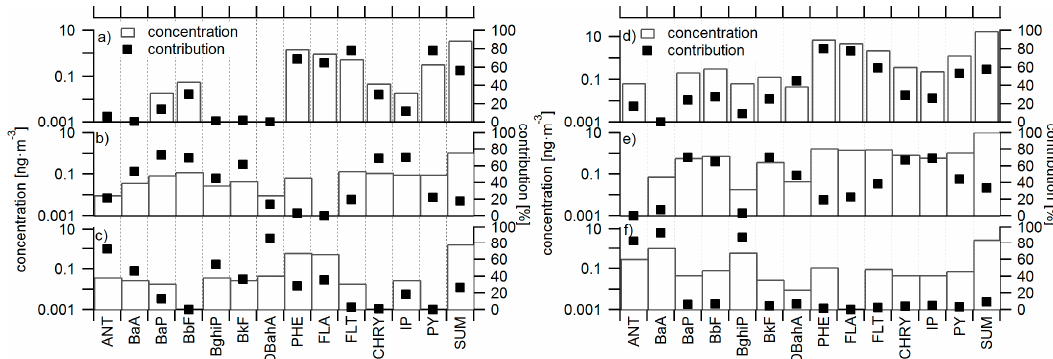
Figure 5. The source profiles with bars representing mass contribution (y-axis on the left) and markers representing contribution in percentage (y-axis on the right) in the warm part of the year, ( a ) combustion, ( b ) mixed emissions, ( c ) volatilizing, and in the cold part of the year, ( d ) combustion, ( e ) mixed emissions, ( f ) natural gas combustion.